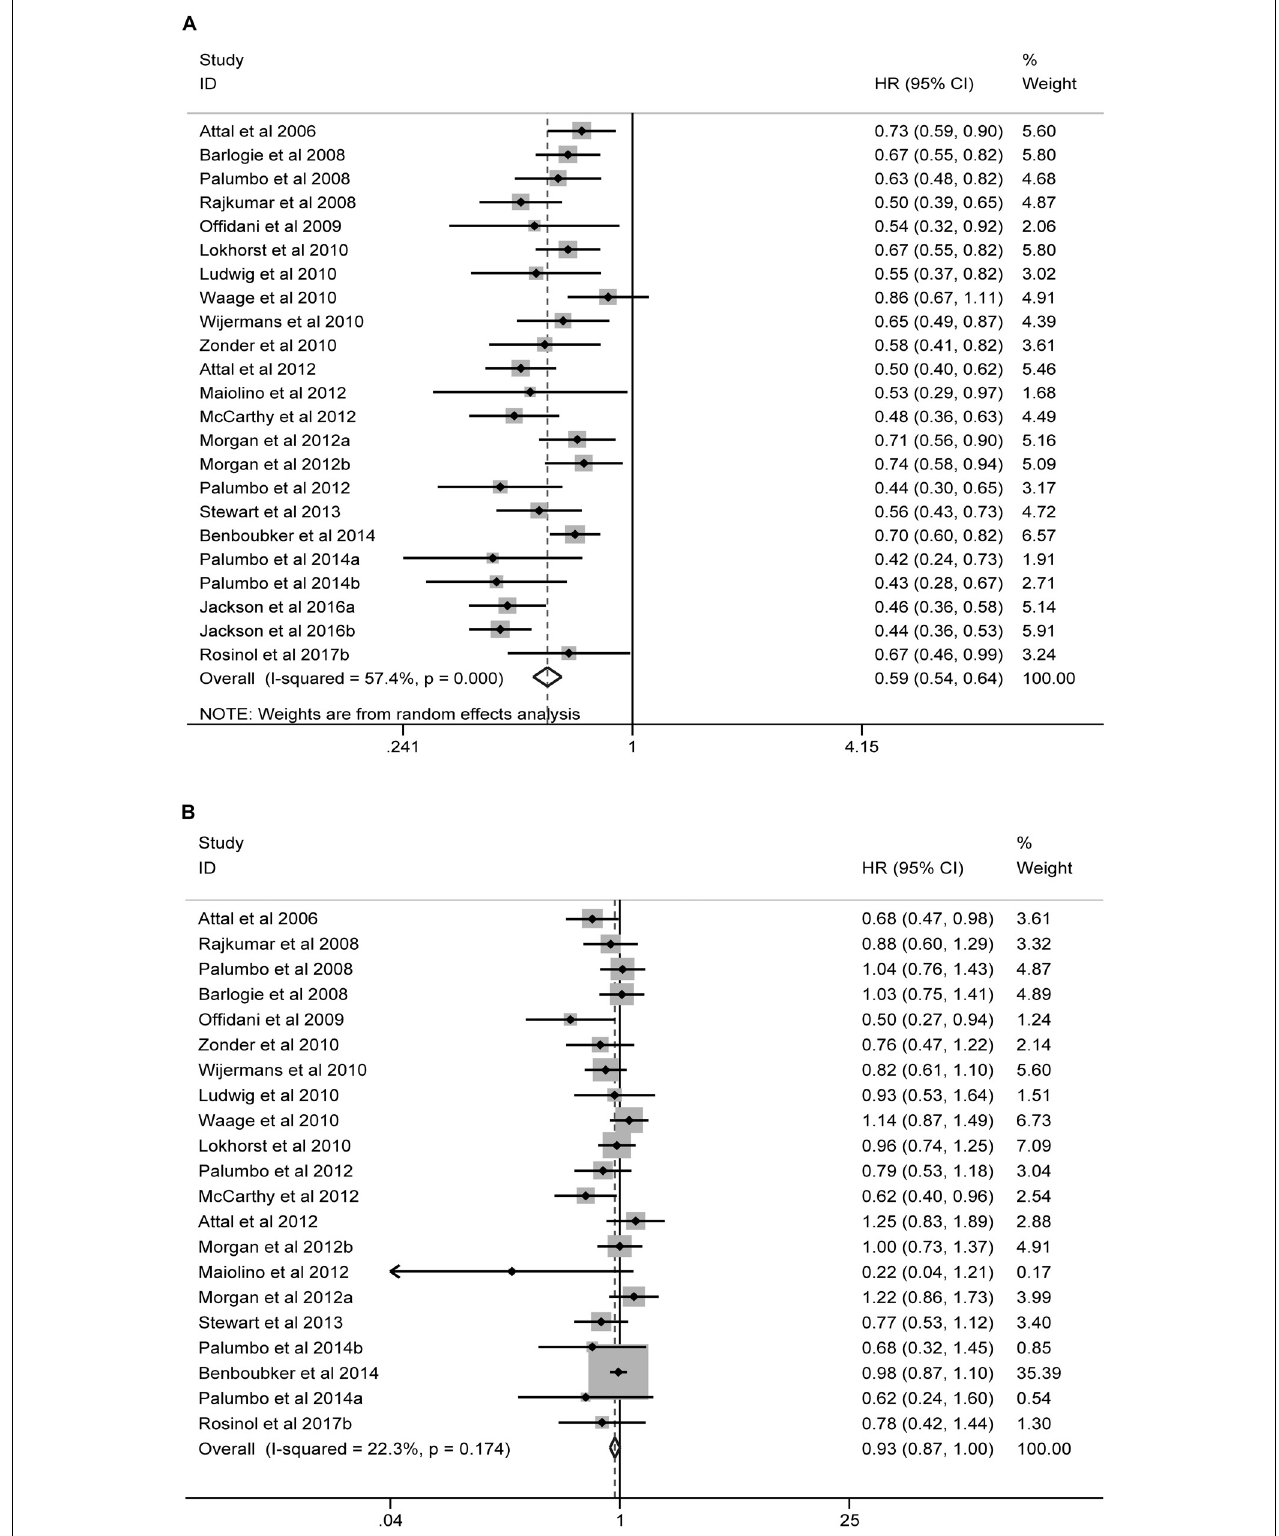
FIGURE 3 | Forest plots of meta-analysis of RCTs comparing maintenance containing new agents and conventional maintenance. Significant and non-significant beneficial effects were found associated with maintenance using new agents, respectively, in terms of PFS (A) and OS (B) .